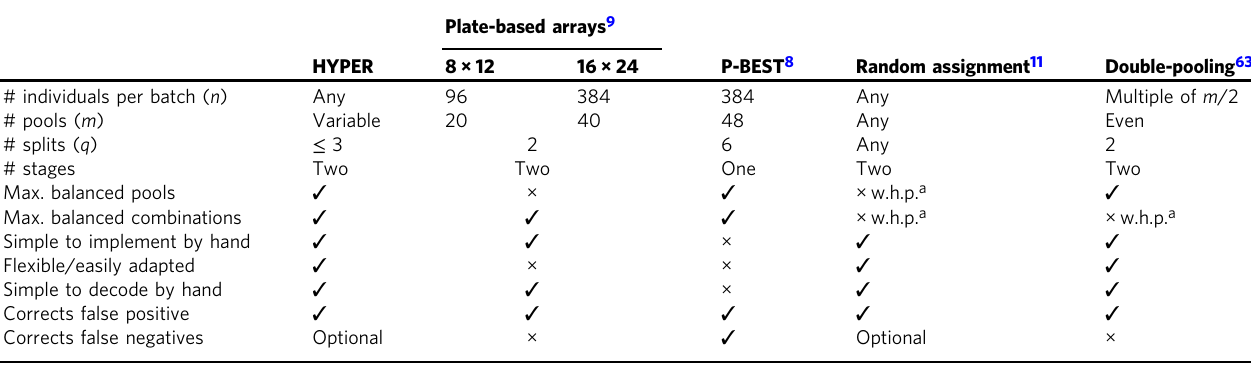
Fig. 1 Illustration of HYPER. Stage 1 tests pools that are formed by cycling through a sequence of pool assignments generated via hypergraph factorization. Putative positives are individuals that are not in any negative pools (decoding). Stage 2 tests the putative positives individually. In this example, n = 12 individuals (2 of whom are actual positives) are each split into q = 2 of m = 6 pools; three are decoded as putative positives and both positives are successfully identi fi ed in stage 2. Table 1 Comparison of various features of HYPER with existing